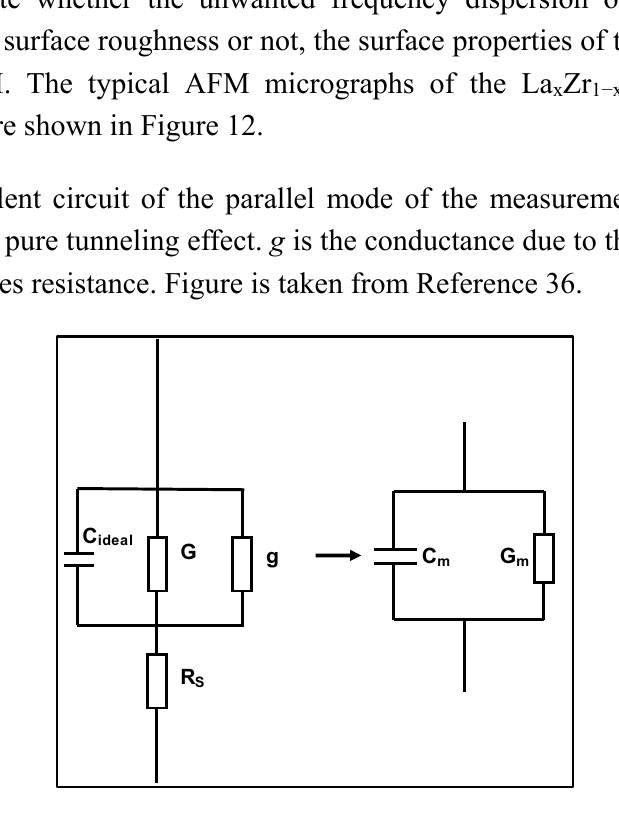
Zr O annealed thin films. ( a ) x = 0.35; x 1 − x 2